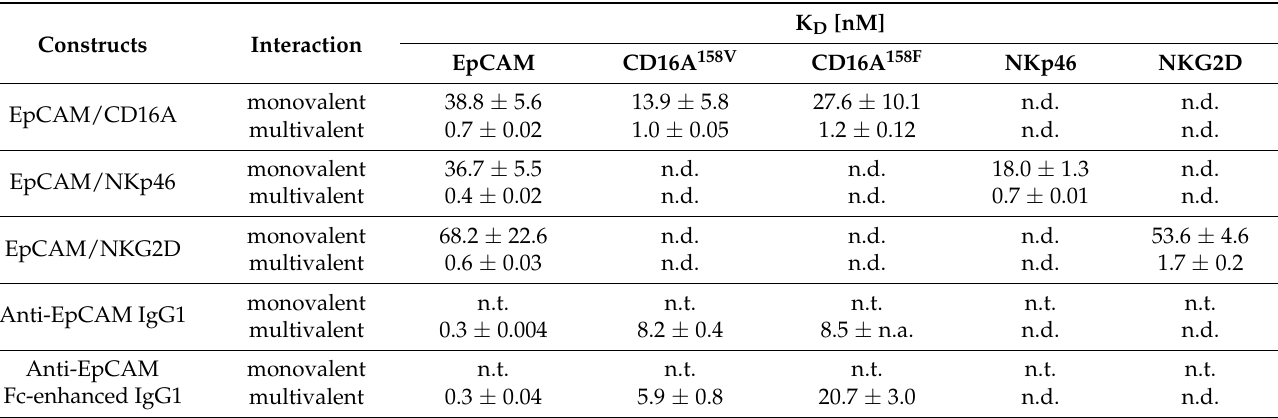
Table 1. The monovalent and multivalent binding affinities of bispecific ICE ® constructs to recombi- nant human EpCAM, CD16A, NKG2D, and NKp46